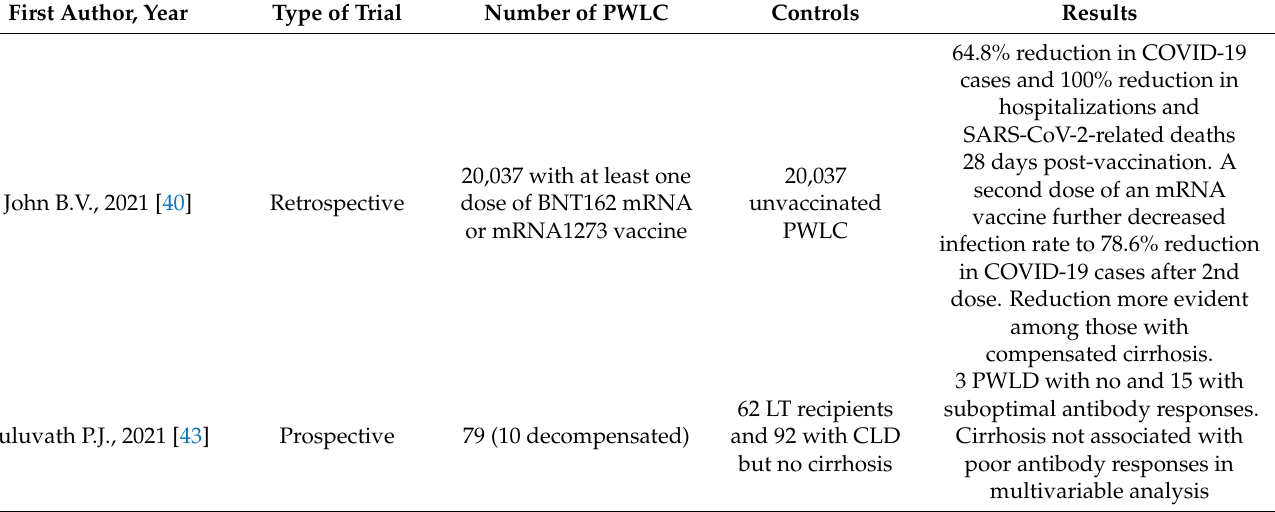
Table 1. Most important studies concerning mRNA-based anti-SARS-CoV-2 vaccines in patients with liver